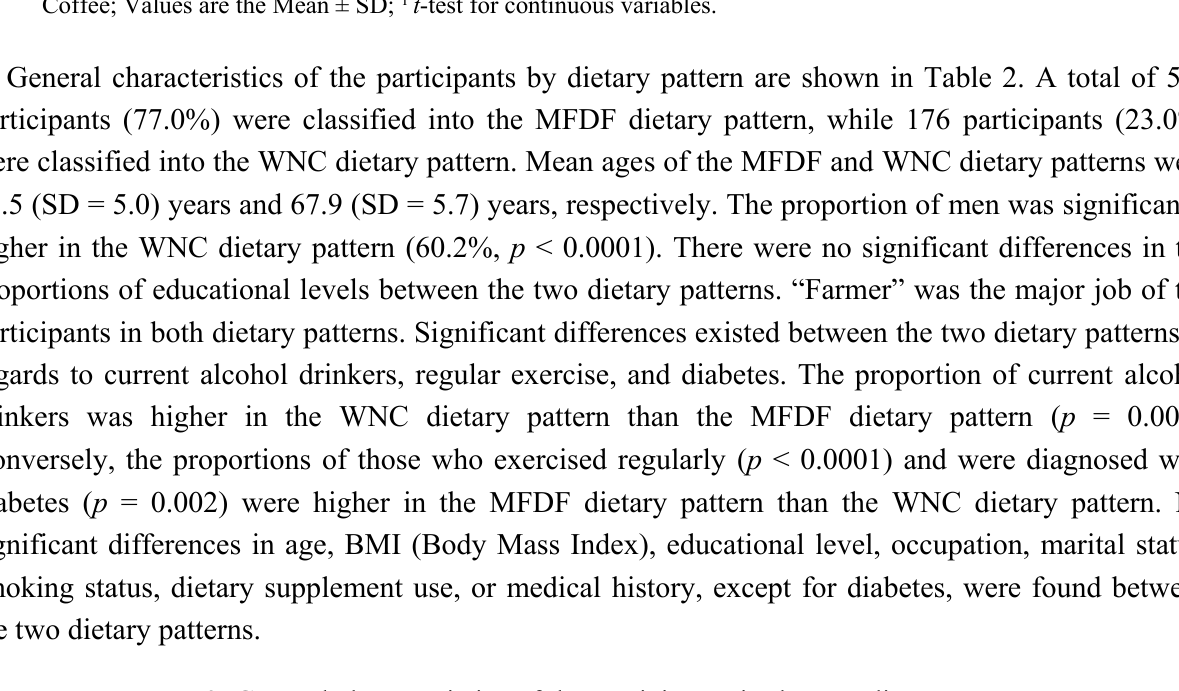
Table 2. General characteristics of the participants in the two dietary